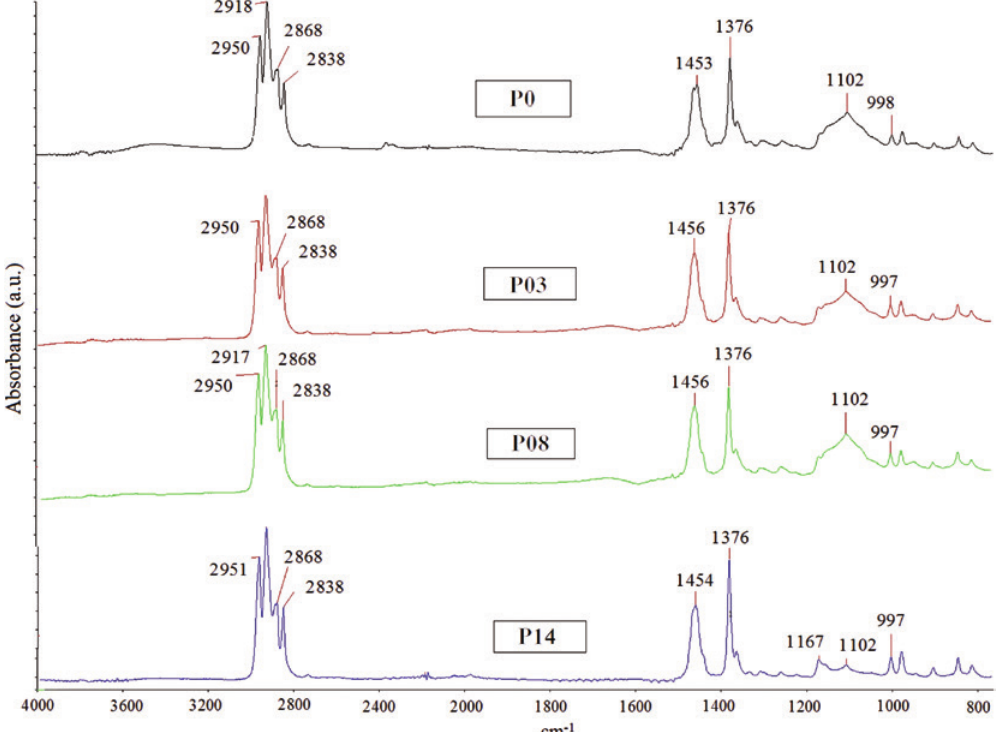
Figure 8: FTIR spectra of the polypropylene filaments.